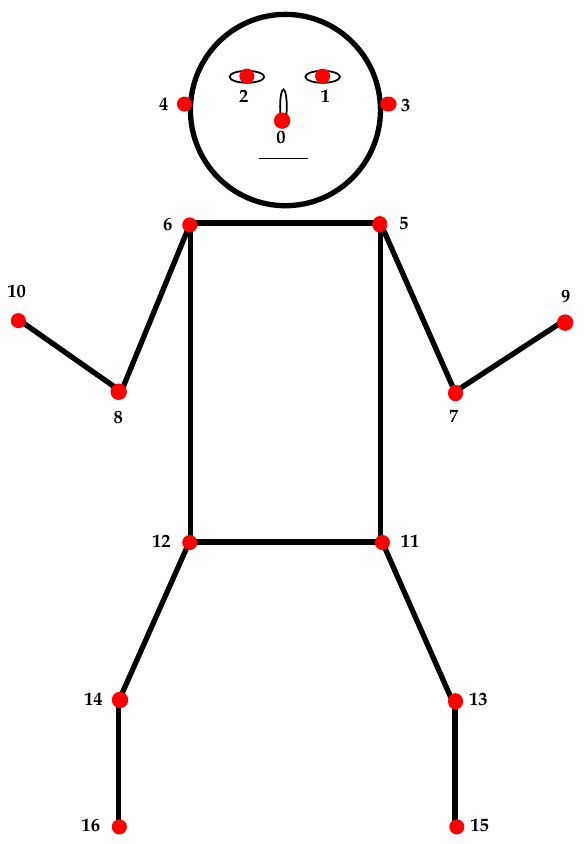
Figure 2. COCO Keypoints: Used in MoveNet and PoseNet. PoseNet model is used with TensorFlow.js package on mobile